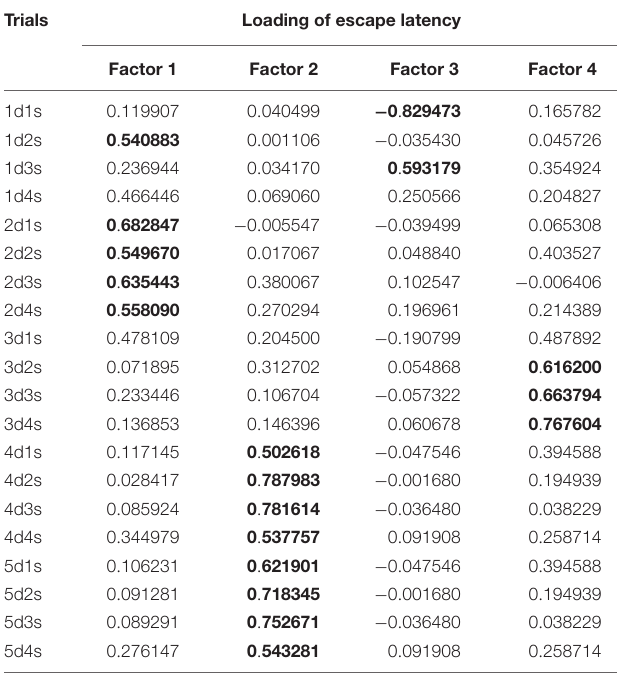
The loadings values higher than 0.5 (the threshold level for Factor interpretation) are in